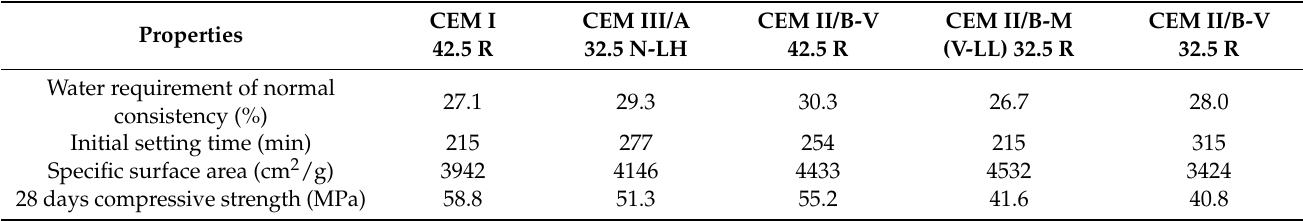
Table 2. Physical and mechanical properties of cements.